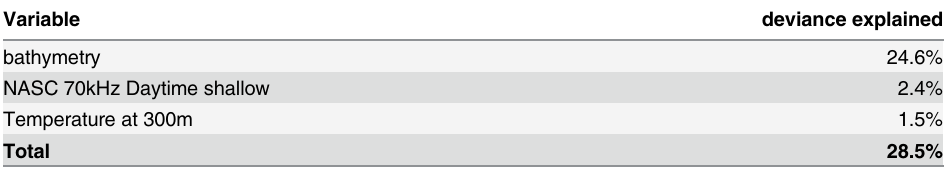
Table 4. Variables in the GAMM for Blainville ’ s beaked whales and amount of deviance explained by